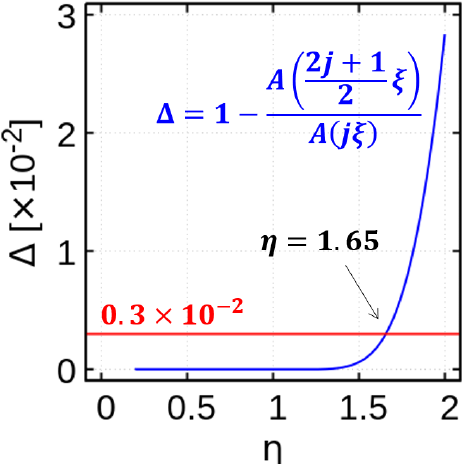
Figure A2. Relationship between the parameter η and the differ- ence (cid:49)